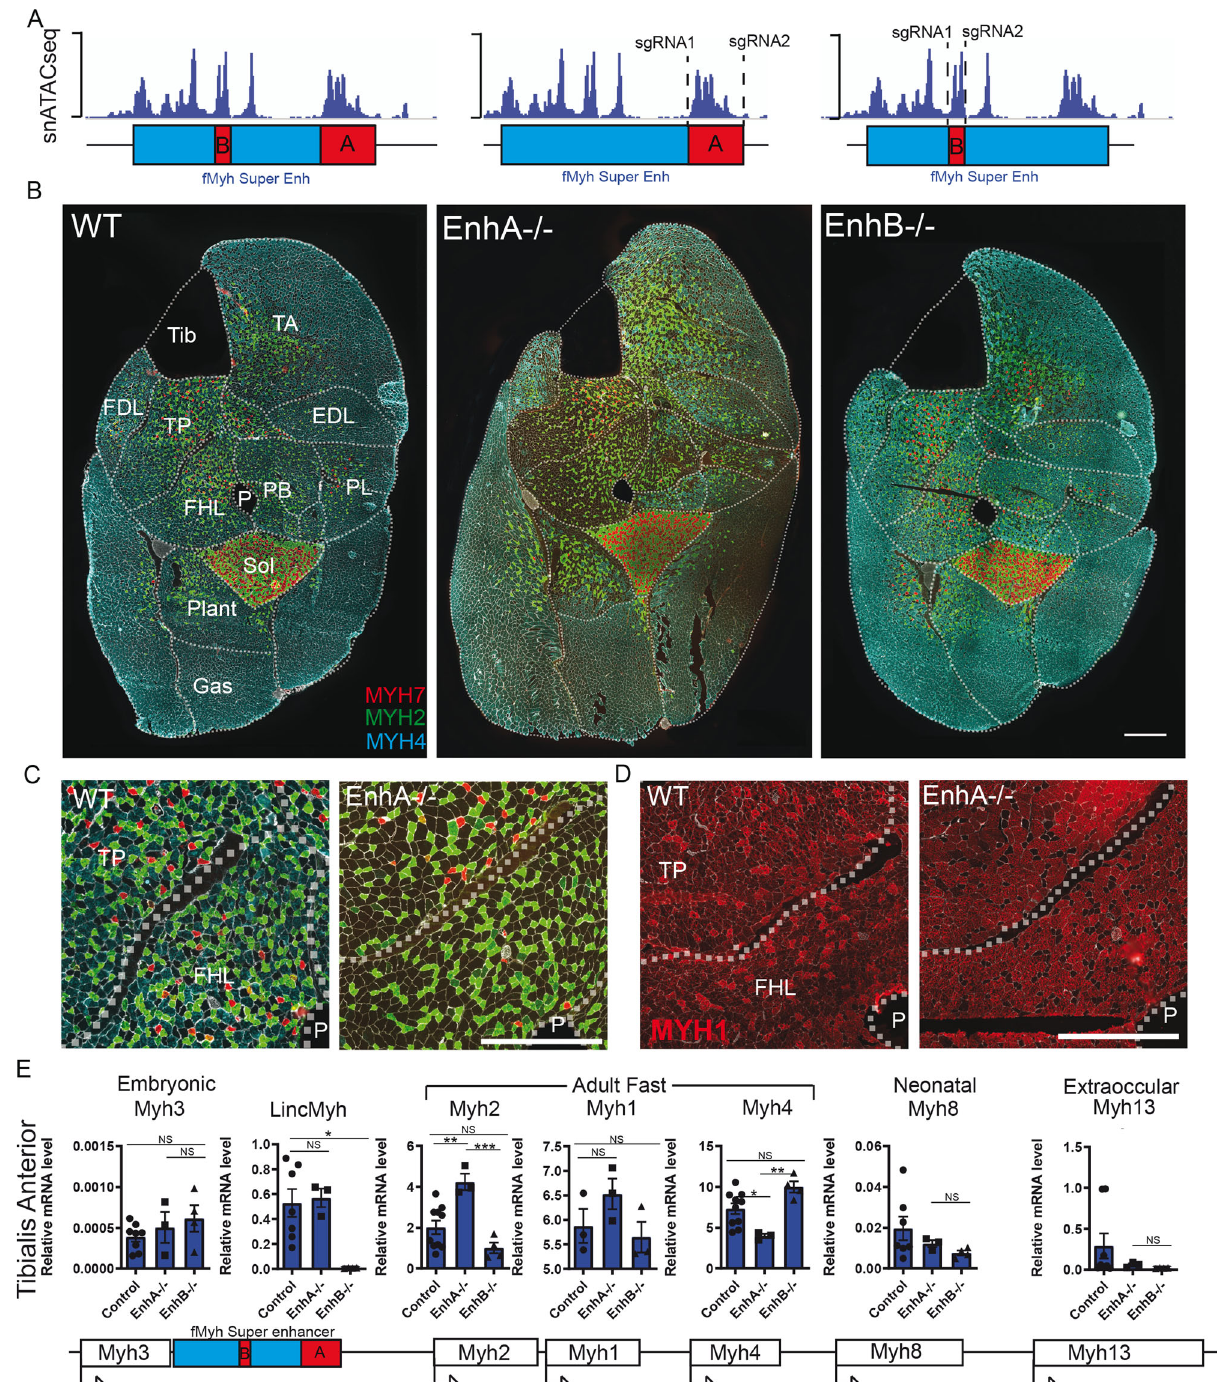
Fig. 4 Role of the different enhancers composing the SE. A Schematic representation of the snATAC-seq peaks along the 42 kb SE and the enhancers A and B deleted by CRISPR/Cas9 editing. B Immunostaining against fast MYH2, MYH4, and slow MYH7 on adult leg sections of 2 – 3-month-old mouse female deleted for enhancer A or B. C Same as B , zoom in Tibialis posterior and FHL muscle of WT and EnhA − / − mutant. D Immunostaining against fast MYH1 in Tibialis posterior and FHL muscle of WT and EnhA − / − mutant. The absence of EnhA induced an increased number of MYH1 positive fi bers. E Quanti fi cation of f Myh mRNA and of Linc-Myh in adult TA of control and EnhA and EnhB mutant by RT-qPCR experiments. For E , n = 3. Numerical data are presented as mean ± S.E.M. * P < 0.05, ** P < 0.01, *** P < 0.001. Scale bars: 100 μ m for B – D . Signi fi cance of difference, for E : one-way ANOVA with multiple comparisons. Source data are provided as a Source Data fi